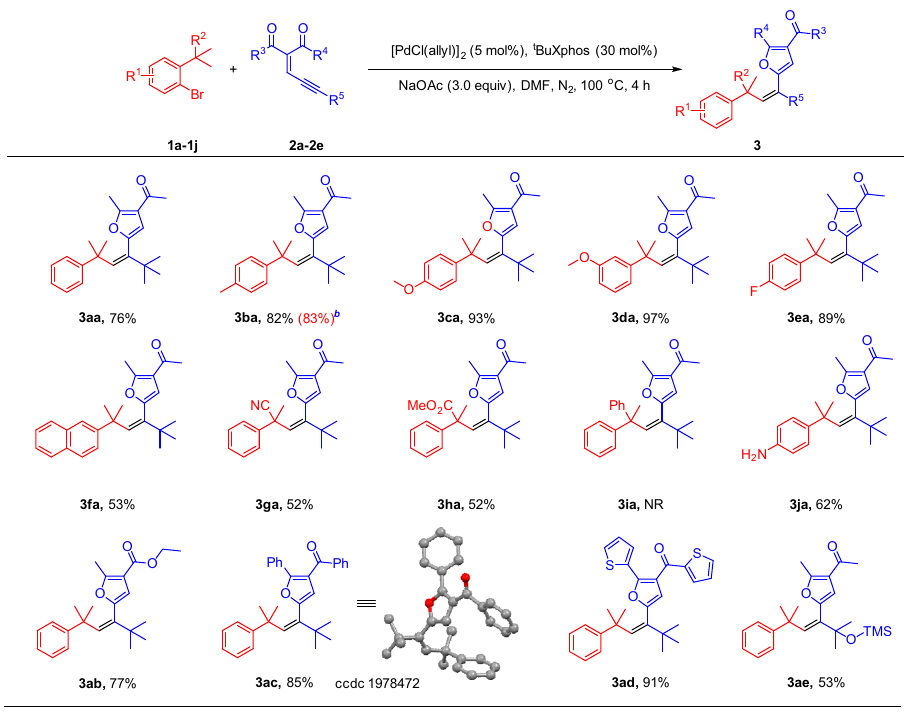
Fig. 2 Substrate scopes of aryl bromides and ene-yne-ketones. [a] Reaction conditions: 1 (0.1 mmol, 1.0 equiv), 2 (0.2 mmol, 2.0 equiv), [Pd(Cl(allyl)] 2 (5 mol%), t BuXphos (30 mol%), NaOAc (3.0 equiv), DMF (1 mL), under N 2 , 100 °C, 4 h. Yields of isolated products. [b] The reaction was run in 2.0 mmol